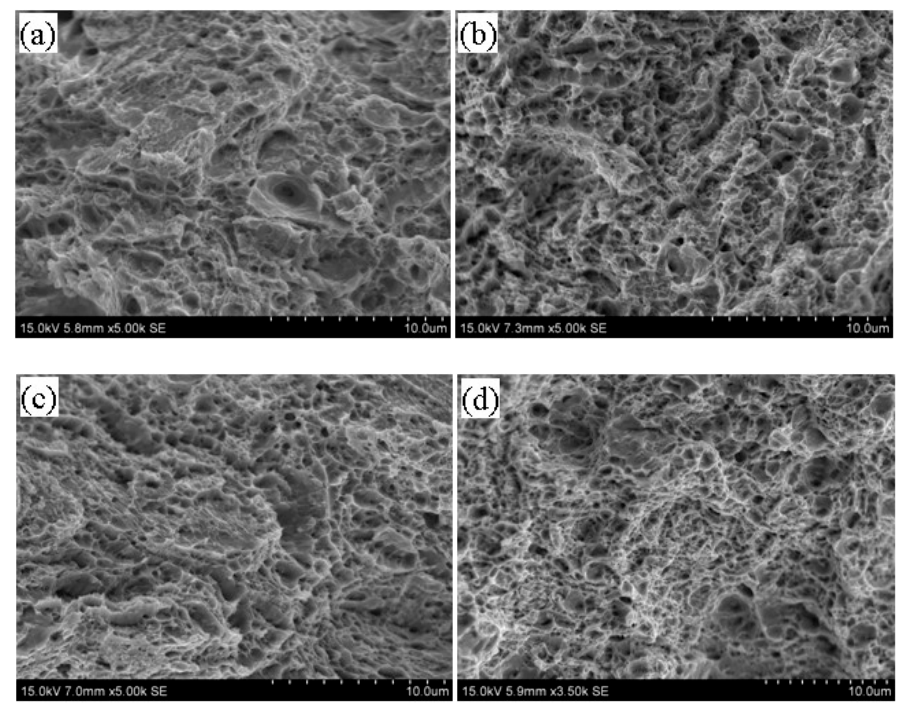
Figure 9. Fracture morphology of tempered 5140 alloy steel before and after tempering at 520 °C: ( a ) 0 protons/cm 2 , ( b ) 2 × 10 14 protons/cm 2 , ( c ) 2 × 10 15 protons/cm 2 , ( d ) 2 × 10 16 protons/cm 2 .